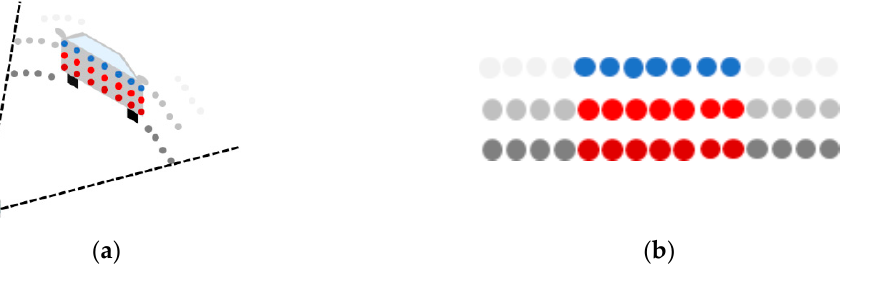
Figure 4. How to display point cloud data : ( a ) output data, ( b ) alignment data.